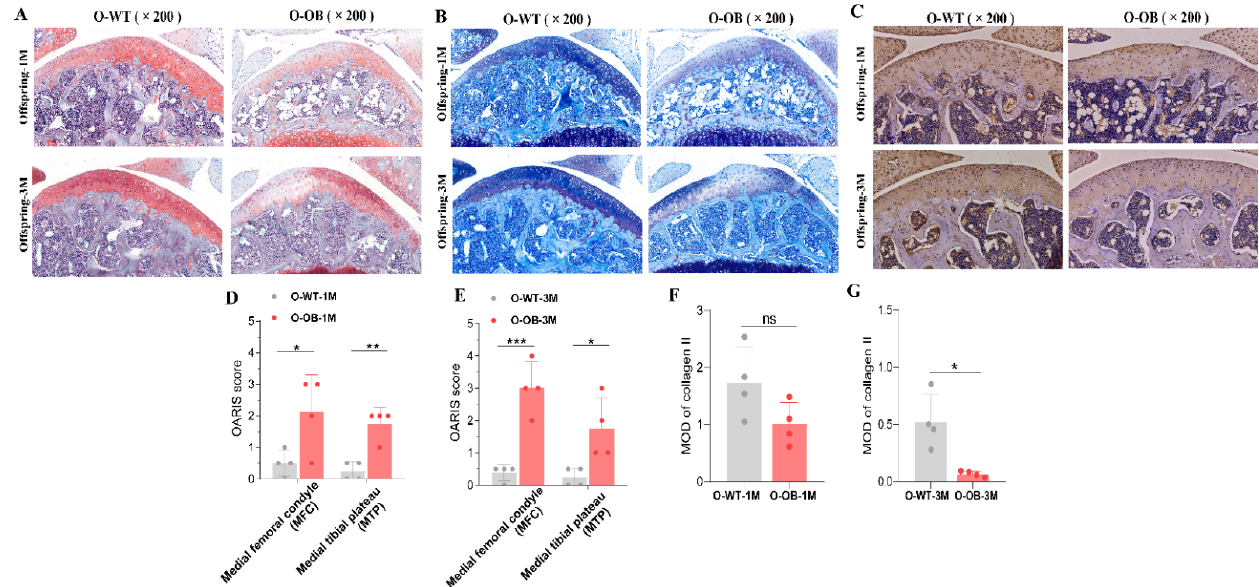
Figure 7. Results of pathological alterations in knee cartilage of 1 ‐ and 3 ‐ month ‐ old male mice. ( A ) Representative images of knee cartilage stained with Safranin O/Fast Green and ( B ) toluidine blue in control versus obese offspring (×200 magnification). ( C ) Representative images of IHC of collagen II in knee cartilage of control versus obese offspring of 1 ‐ and 3 ‐ month ‐ old mice (×200 magnification). ( D ) Statistical results of the OARIS score for 1 ‐ and ( E ) 3 ‐ month ‐ old mice cartilage. ( F , G ) Statistical results of IHC ‐ stained collagen II in each group. 1M: 1 ‐ month ‐ old male mice from the control or obese mothers. 3M: 3 ‐ month ‐ old male mice from the control or obese mothers. n = 4 represents four male mice in each group from four litters of different mothers. Results are expressed as mean ± SD. ns not significant, * p < 0.05, ** p < 0.01, and *** p < 0.001.